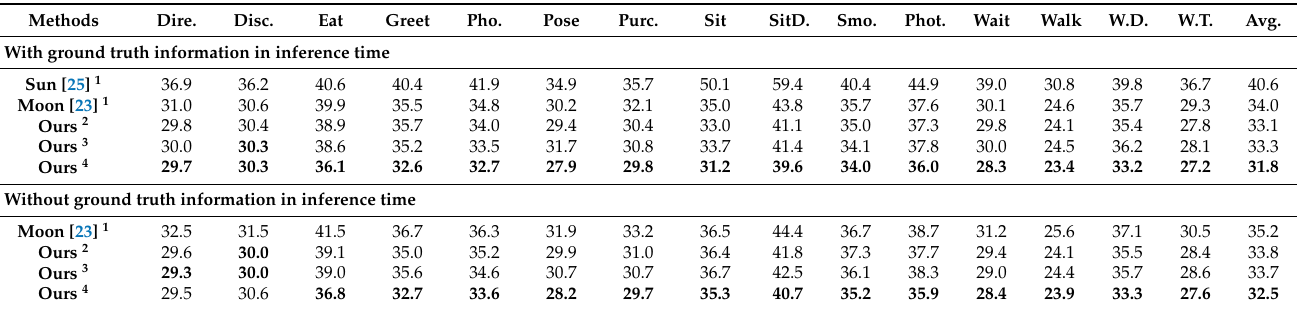
Table 2. Quantitative comparisons with the base model on the Human3.6M under Protocol 1 (PA- MPJPE). Best results are in